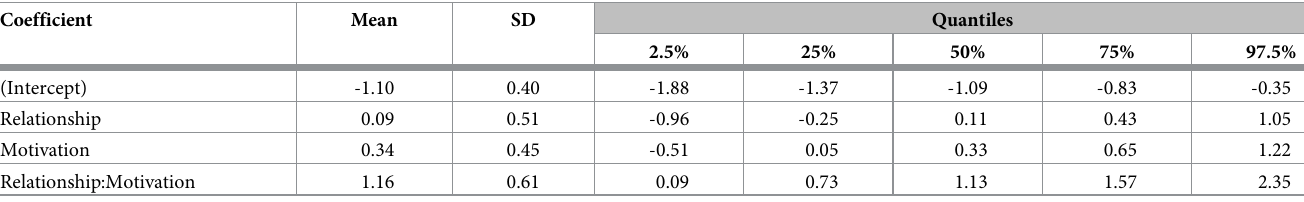
Table 9. Summary statistics of Bayesian GLM using vaguely informative